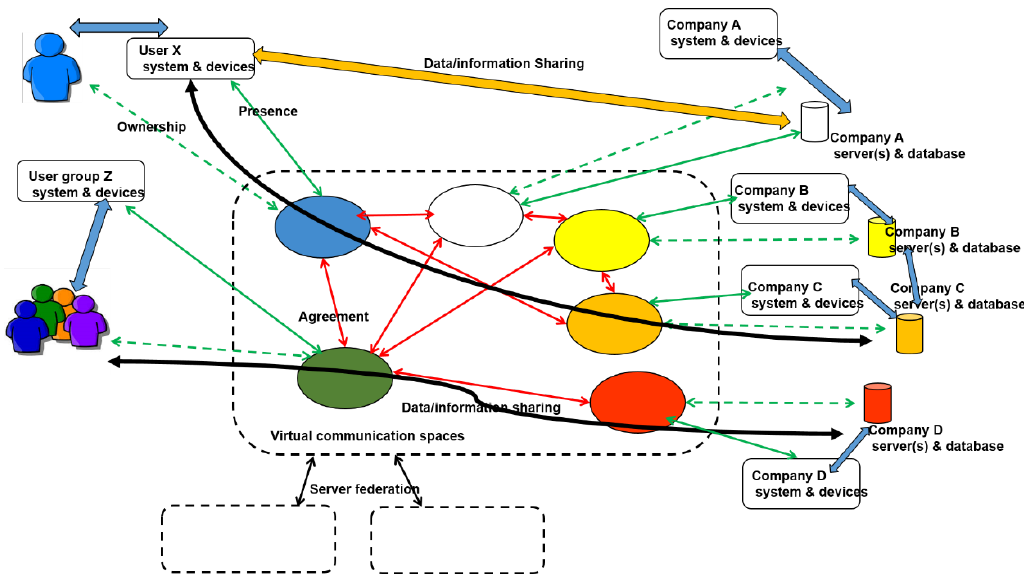
Figure 3. An example logical structure of a CPS communication hub.